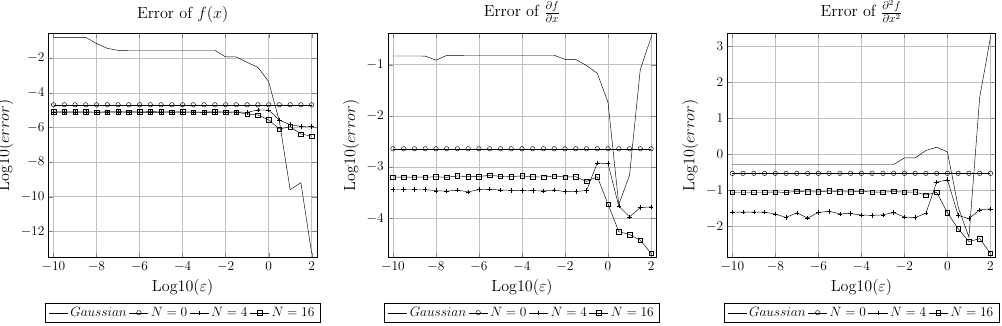
Figure 2. Error in approximating the given function f ( x ) and its first two derivatives using Gaussian RBF approach and Hermite expansion approaches as they vary with ε . The number of mesh points is fixed at 80 stretched points within the range [ 1,1]. −